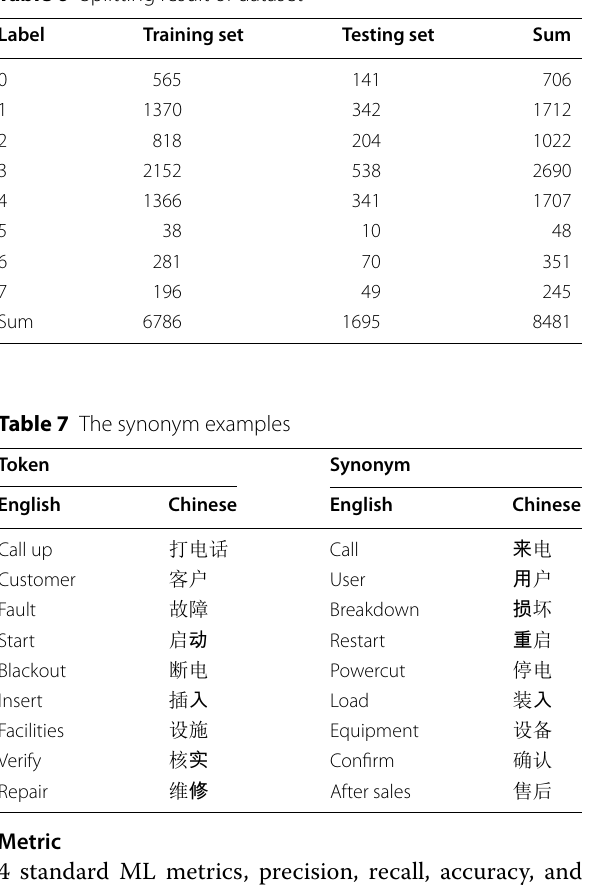
Table 6 Splitting result of dataset